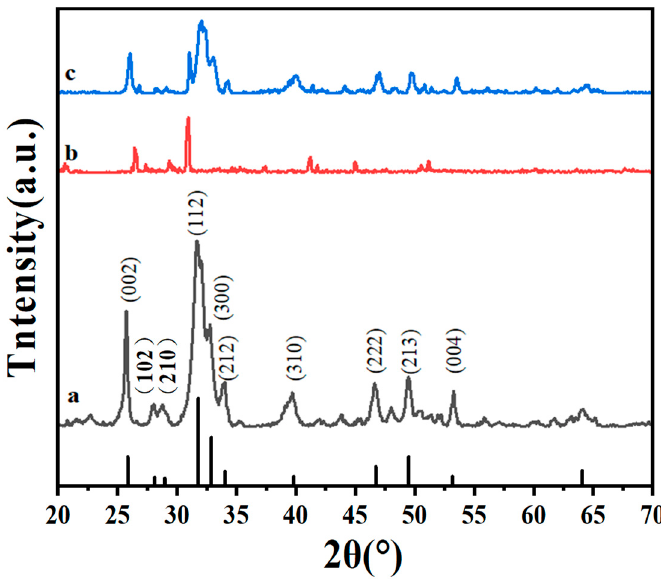
Figure 2. XRD patterns of ( a ) nano-HAp, ( b ) PU sponge, and ( c ) nano-HAp/PU sponge.